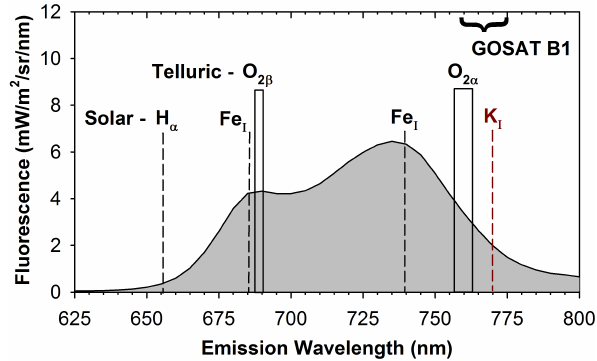
Fig. 1. Simulated solar-induced fluorescence as a function of the emission wavelength with locations of oxygen absorption bands and several solar Fraunhofer lines indicated including the K I line used here.